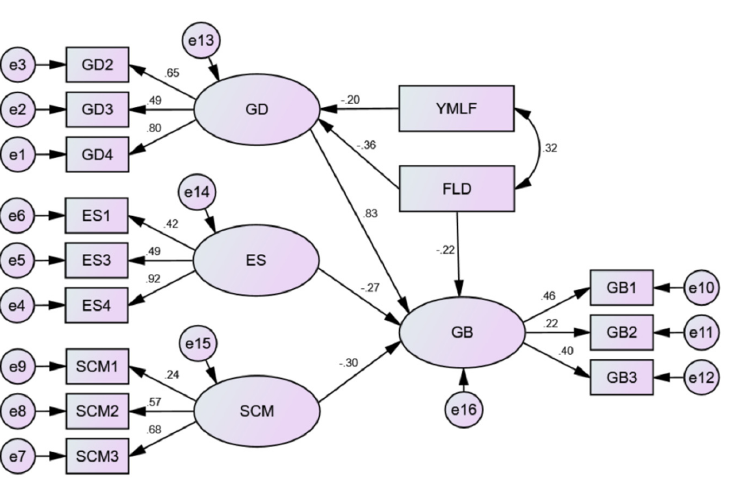
Figure 3. Structural equation model for influencing factors of grazing behavior (GD means Grassland Dependence. ES means Environment Sensitivity. SCM means Satisfaction with compensation mechanism. YMLF means Young and Middle-aged Labor Forces. FLD means Family Livelihood Diversification. GB means Grazing Behavior).